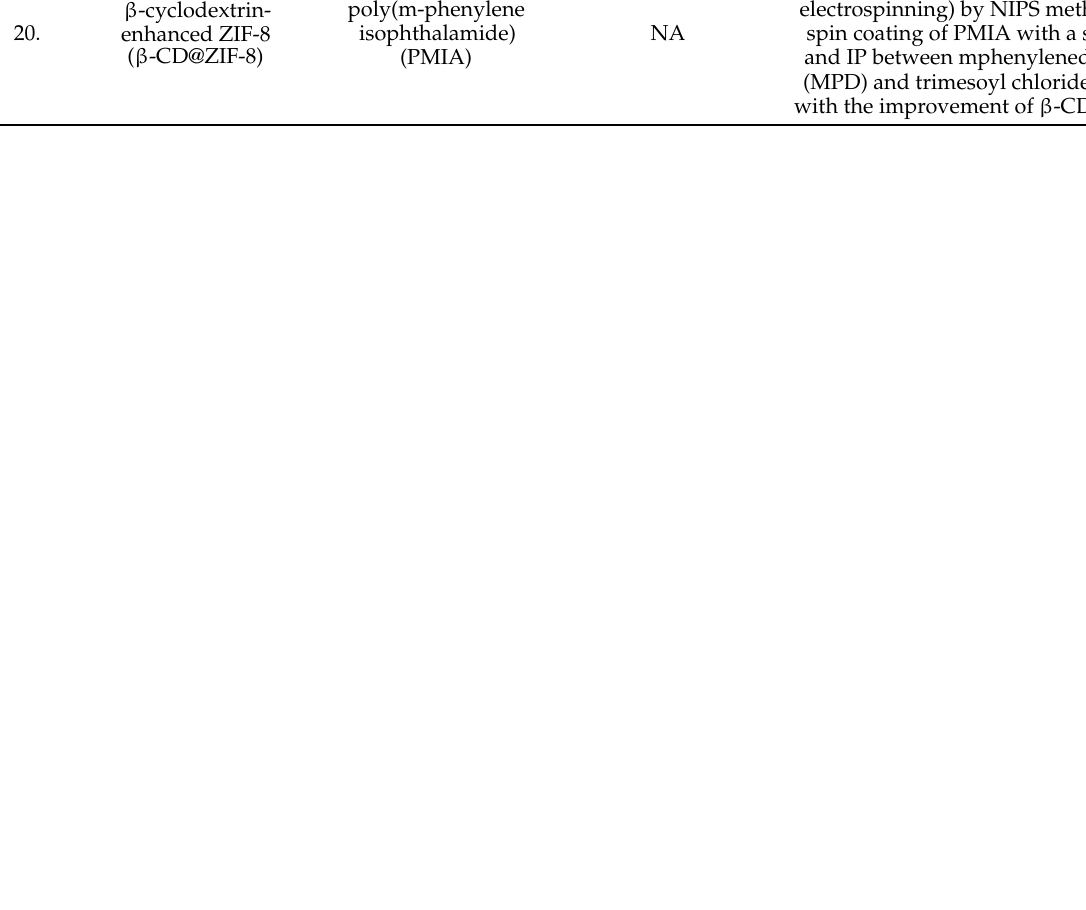
The PMIA support layer formed onto the PI nanofiber (formed by electrospinning) by NIPS method and spin coating of PMIA with a spinner and IP between mphenylenediamine (MPD) and trimesoyl chloride (TMC) with the improvement of β